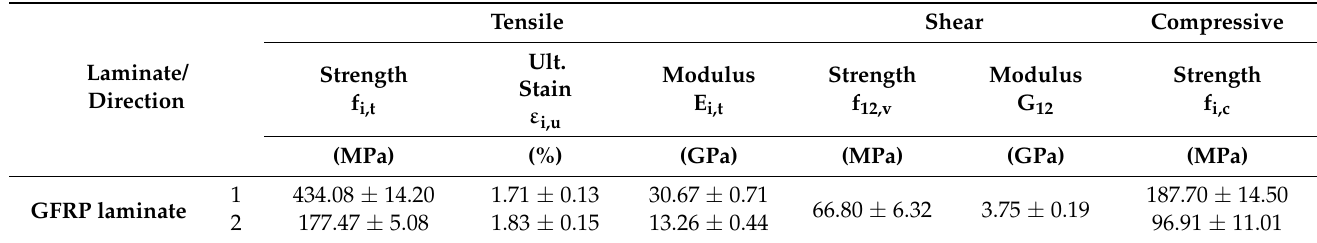
Table 5. Test results for target GFRP face